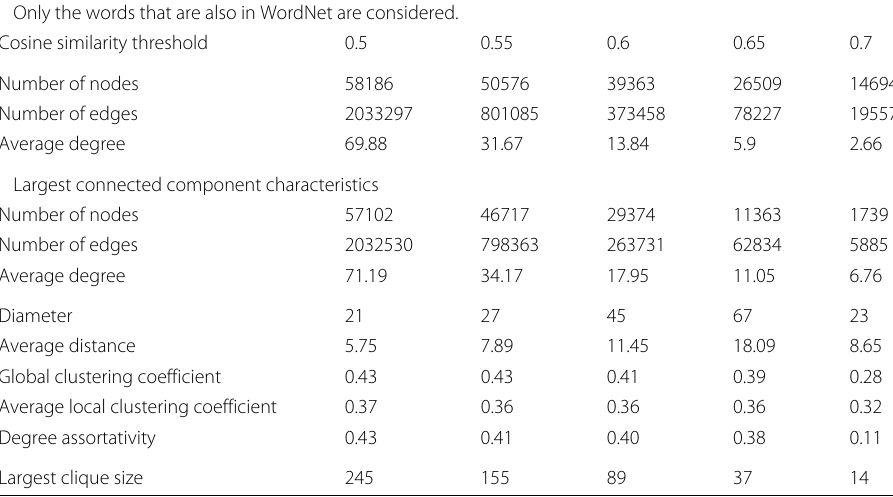
Table 5 Basic characteristics of the Google News word embedding-based similarity networks obtained for various slicing thresholds on cosine similarity among the corresponding vectors Only the words that are also in WordNet are